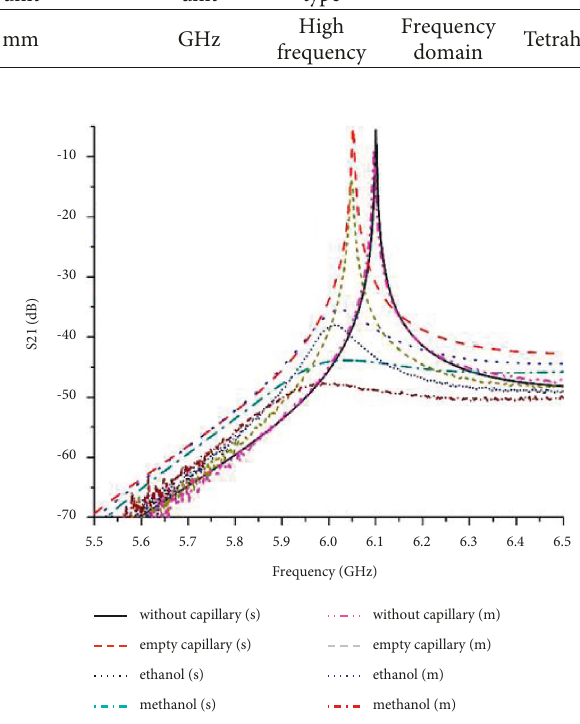
Figure 8: Predicated (s) and measured (m) S21 of the stated sensor with/without LUT.